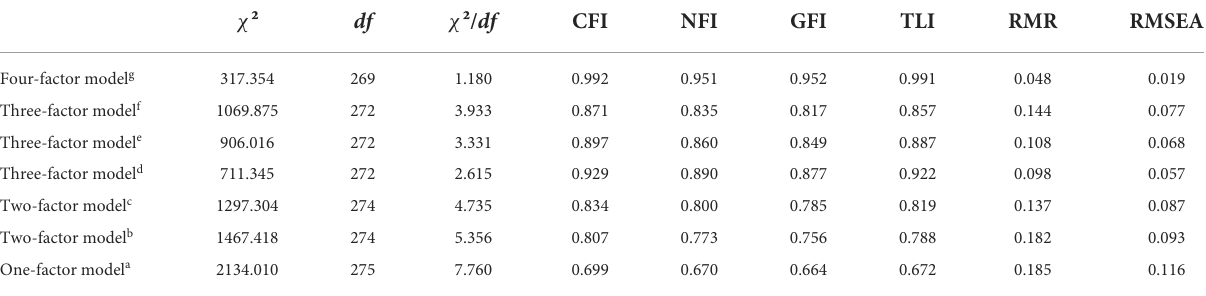
TABLE 2 Confirmatory factor